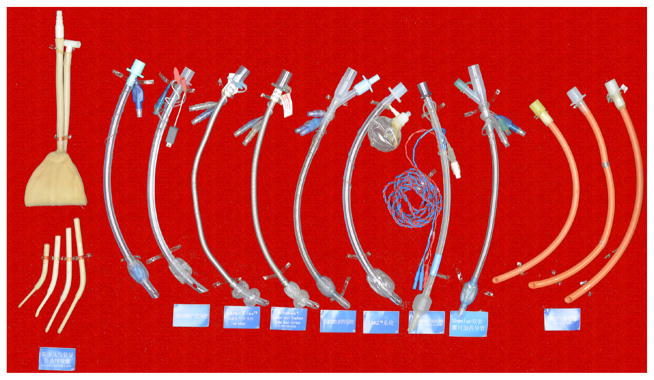
Laser tube, et al.